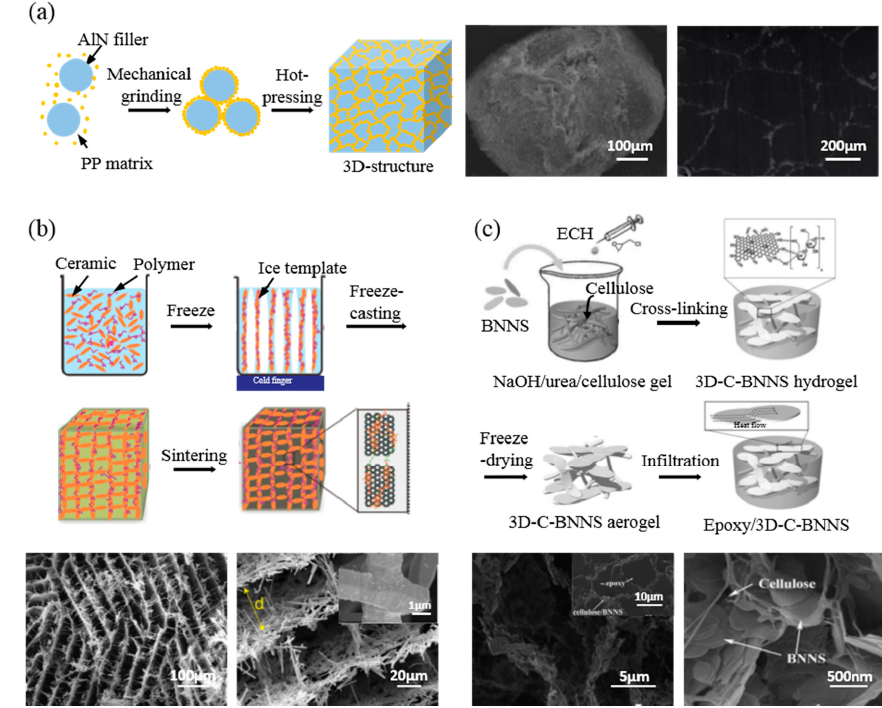
Figure 4. Schematic illustration of 3D networking of ceramic fillers/polymer composites and SEM